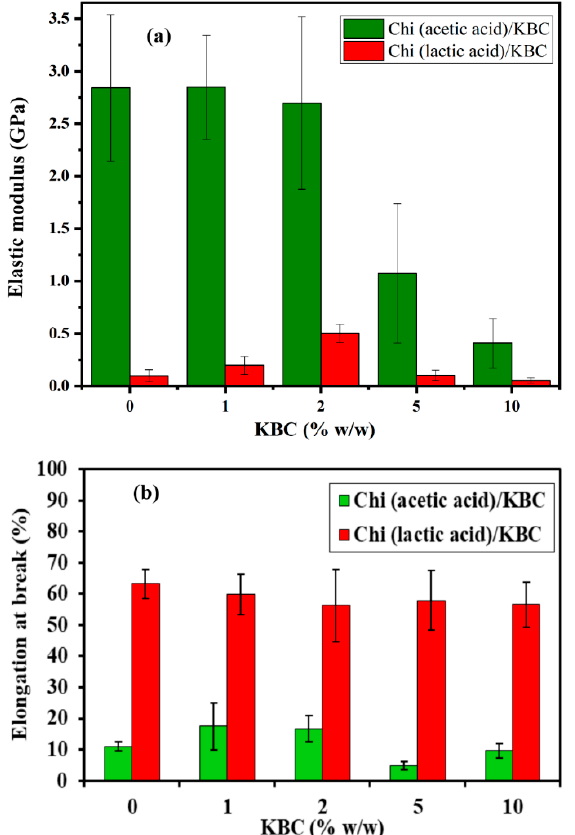
Figure 5. ( a ) Elastic modulus and ( b ) Elongation at break of Chi films modified by KBC; bars represent mean ± SD (standard deviation).